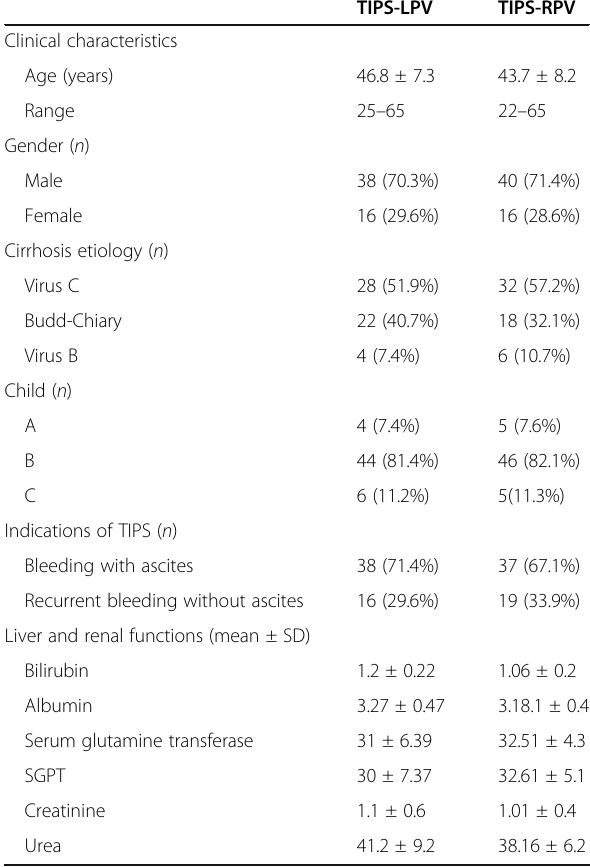
Table 1 Demographic data of patients in both studied groups Table 3 Encephalopathy after TIPS in both studied TIPS-LPV